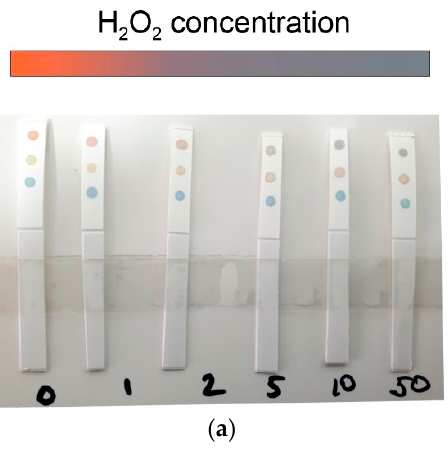
Figure 6. ( a ) Color change in nanoparticles deposited on a nitrocellulose membrane upon incubation with hydrogen peroxide at a concentration of 0–50 mM. Nanoparticles were obtained using Ag-to-Au molar ratios of 2.5 (upper dots), 5 (middle dots), and 1.25 (bottom dots). The color decoding bar is shown on the top; ( b ) an example of measurement of H 2 O 2 in the spiked milk sample.